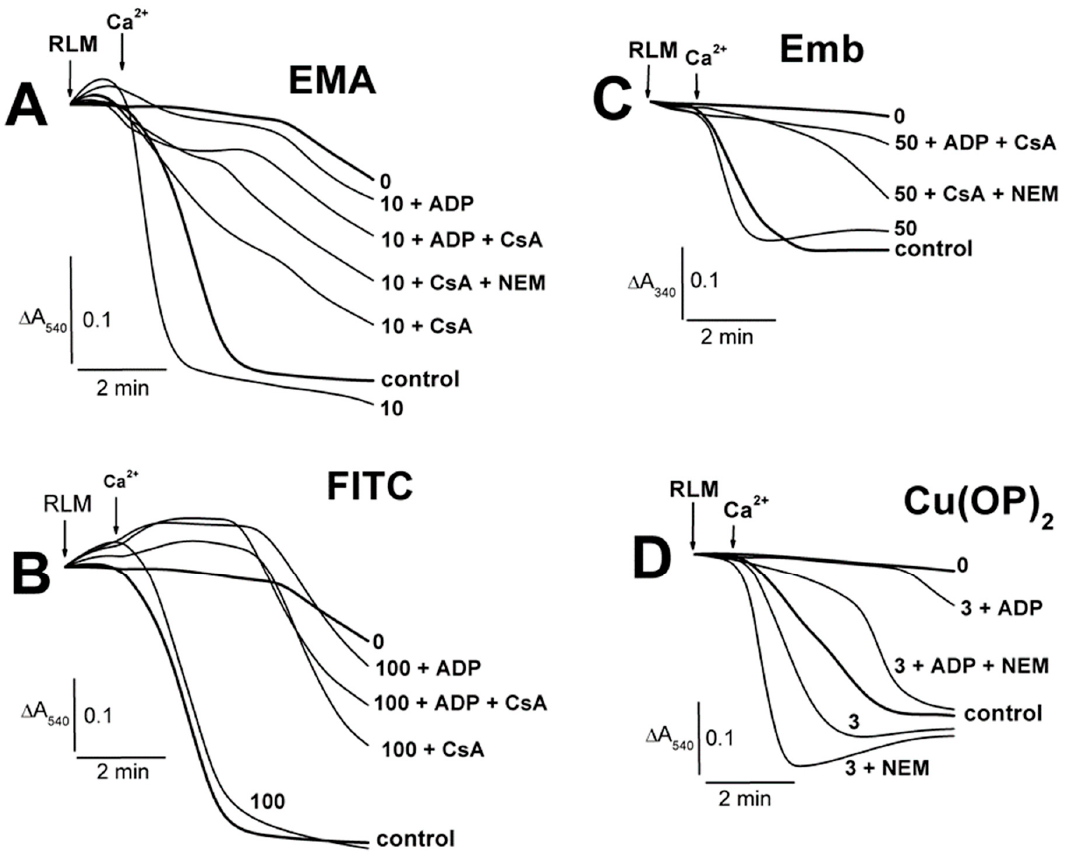
Figure 6. The influence of Ca 2+ on the Tl + -induced swelling of succinate-energized rat liver mitochondria in the presence of EMA, FITC, Cu(OP) 2 , and Emb. Mitochondria (1.5 mg of protein per mL) were added into the medium A containing 75 mM TlNO 3 and 5 mM Tris-succinate (pH 7.3). The numbers on the right of the traces show concentrations ( µ M) of EMA ( A ), FITC ( B ), Cu(OP) 2 ( C ), and Emb ( D ), injected into the medium before mitochondria. Additions of mitochondria (RLM) and 75 µ M Ca 2+ (Ca 2+ ) are shown by arrows. The medium (where indicated) was additionally supplemented by 500 µ M ADP (ADP), 1 µ M CsA (CsA), and 50 µ M NEM (NEM). The bold traces show experiments free of Ca 2+ (0) or ones with Ca 2+ alone